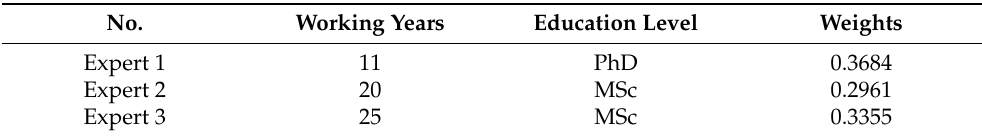
Table 3. The importance and weight of decision makers.